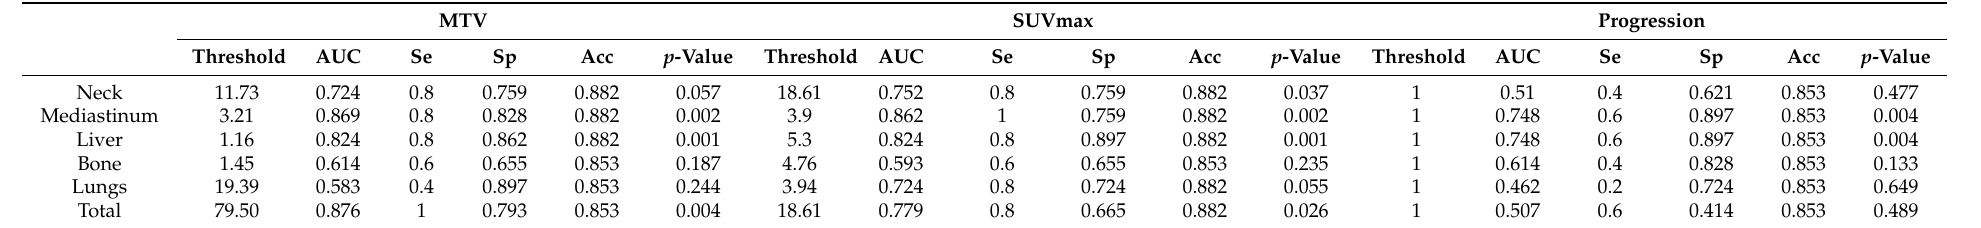
Table 3. Diagnostic performance of parameters measured on 18FDG PET/CT for 1-year overall survival using a ROC analysis. AUC: area under the curve, Se: sensitivity, Sp: specificity, Acc: accuracy.